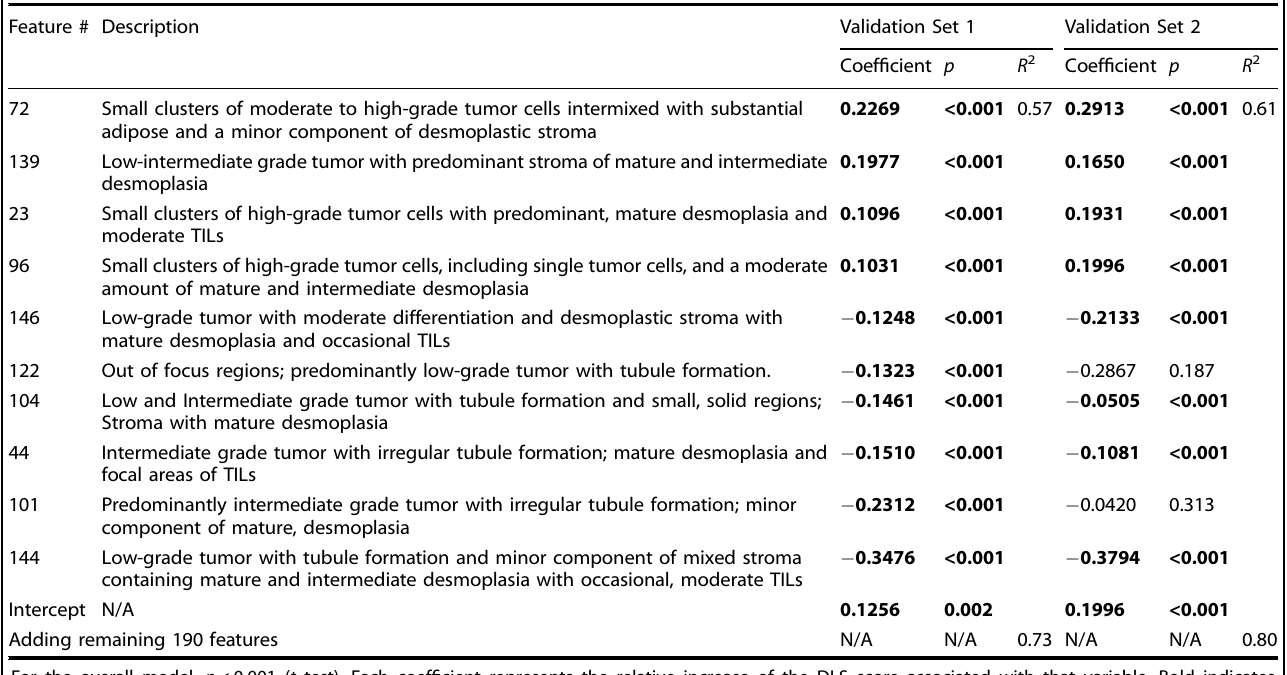
Table 5. Multivariable regression of case-level DLS score using clustering-derived features as input. Feature #